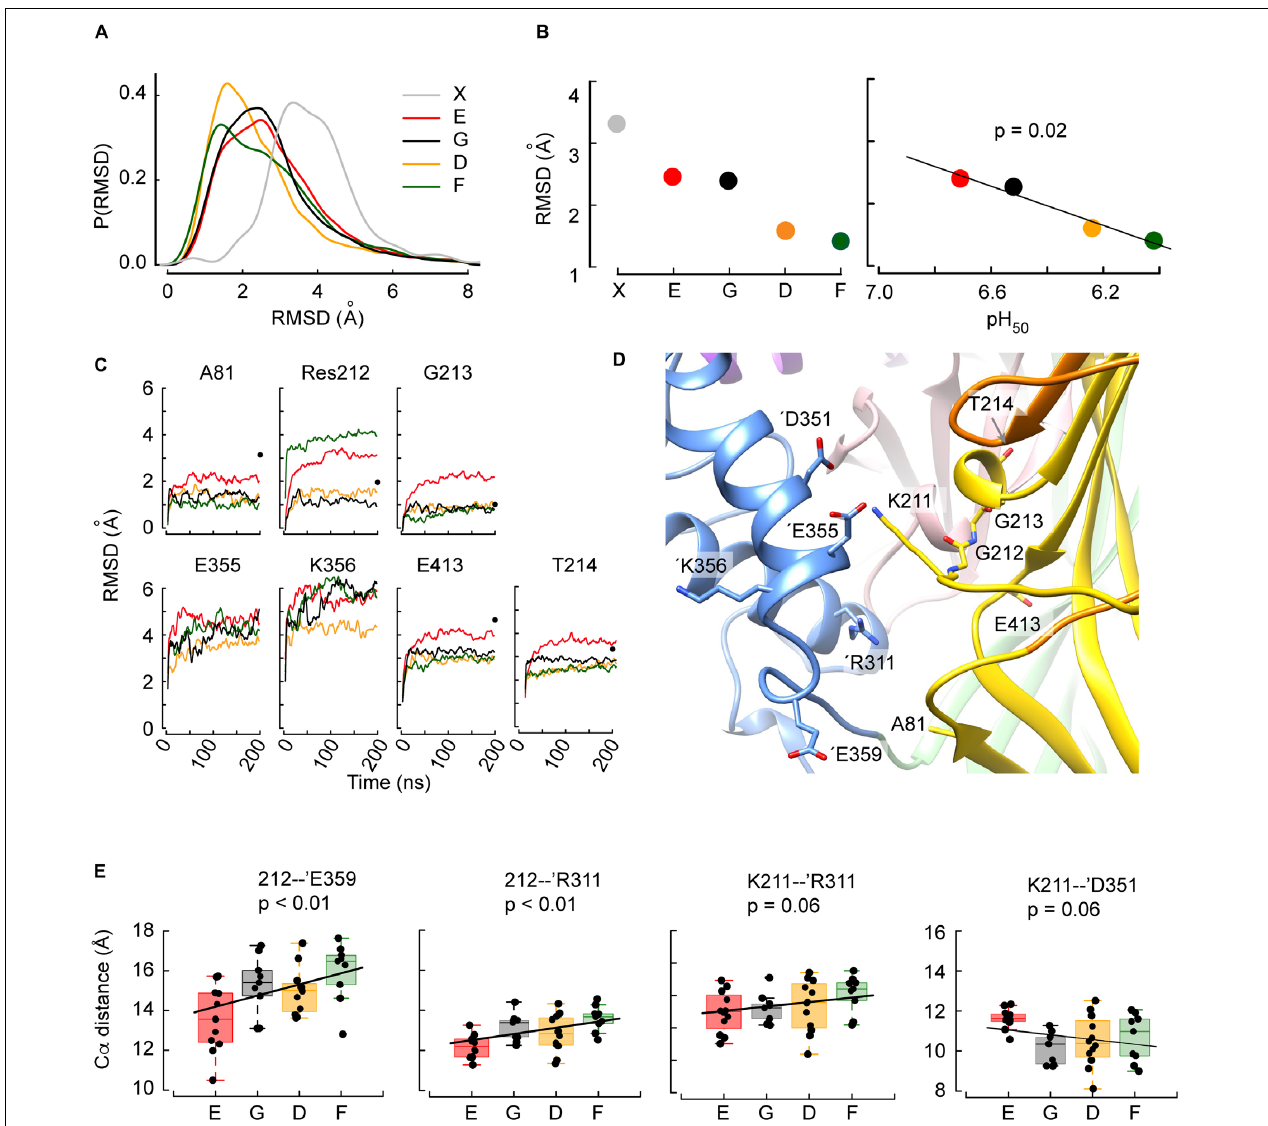
FIGURE 3 | The structural deviations from the initial conformation and intersubunit distances obtained in MD simulations correlate with the pH 50 . (A) Distribution frequencies of the backbone root-mean-square deviations (RMSD, Å) of the residues located within 15 Å of residue 212, determined in MD simulations of G212E (red), WT (G212, black), G212D (orange), and G212F (dark green) of time points 50-200 ns relative to the initial structure, and between the closed (PDB code 5WKU) and open (4NTW) crystal structures (gray). (B) Left: Peaks of the distribution as a function of the mutants, sorted, from left to right, in the order of increasing acidic pH 50 . Right: Correlation between the pH 50 and the RMSD for the investigated constructs. For comparison, the corresponding RMSD of the channel upon opening calculated from the crystal structures is shown in gray in (A,B) . (C) RMSD time series representations of the seven residues for which there was a statistically significant correlation between the RMSD and the pH 50 ranking. The color code is as in (B) . Black dots at 200ns indicate the RMSD of the given residue between the closed and open structural model. For E355 and K356, the RMSD between the closed and the open structural model, not shown in the figure, is 8.9 and 11.4 Å, respectively. (D) Molecular representation of the area around position 212. The residues most affected by the mutation at position 212 and ’Arg311 are depicted in sticks and colored by atom types with nitrogen blue, oxygen red and carbon according to the domains they belong to. Note that the backbones of Gly212 and Gly213 are shown. (E) Correlations between mutants sorted in the order of increasing acidic pH 50 and averaged distances between C α atoms of Res 212 and ’Glu359, Res 212 and ’Arg311, Lys211 and ’Arg311, or Lys211 and ’Asp351. In all panels, the box plots display the median, the 25–75% range (box) and estimated minima and maxima. The linear regression parameters are calculated through least square